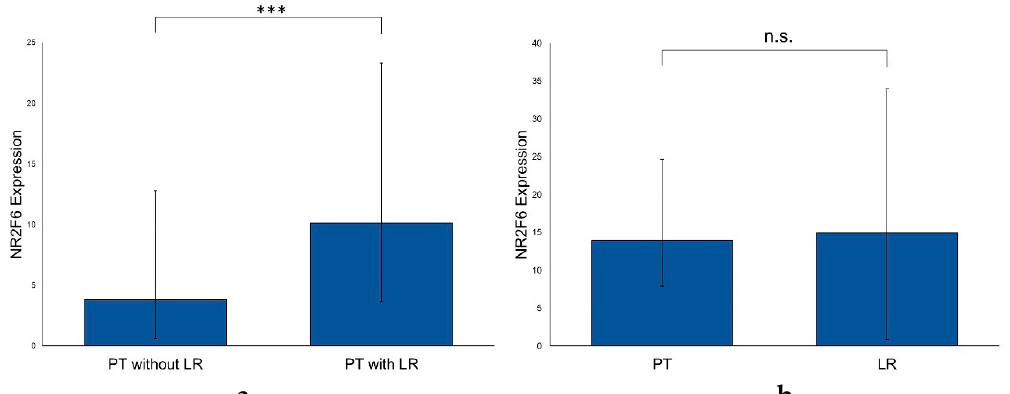
Figure 5. Correlation of NR2F6 expression in PTs with and without LRs and NR2F6 expression in PTs with matching LRs. ( a ) The NR2F6 expression in PTs with LRs was significantly higher than in PTs without LRs (Mann–Whitney test, p < 0.001). ( b ) The NR2F6 expression in PTs and matched LRs was not statistically significant (Wilcoxon signed-rank test, p = 0.664). (*** p ≤ 0.001; n.s. = not significant).